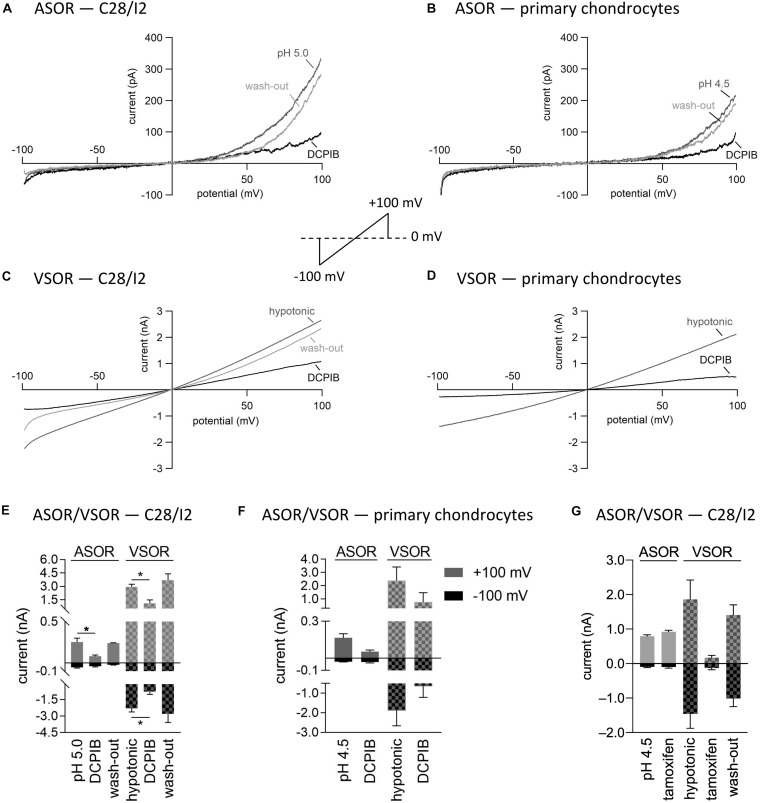
Volume- and acid-sensitive outwardly rectifying (VSOR and ASOR) current sensitivities to the Cl– channel blockers DCPIB and tamoxifen. (A,B) and (C,D) Representative current–voltage relationship obtained by 500-ms voltage ramps under acidic and hypotonic conditions in the absence and presence of DCPIB (10 μM) in C28/I2 cells and primary human chondrocytes, respectively. (E,F) Mean peak currents ± SEM under acidic and hypotonic conditions in the absence and presence of 10 μM DCPIB in C28/I2 (n = 2–4) and primary chondrocytes (n = 2–3), respectively. (G) Mean peak currents ± SEM under acidic and hypotonic conditions in the absence and presence of 10 μM tamoxifen in C28/I2 (n = 3). Asterisks in (E) Indicate significant differences between pH 5.0 and DCPIB and between hypotonic and DCPIB (p < 0.05). Paired t-tests.